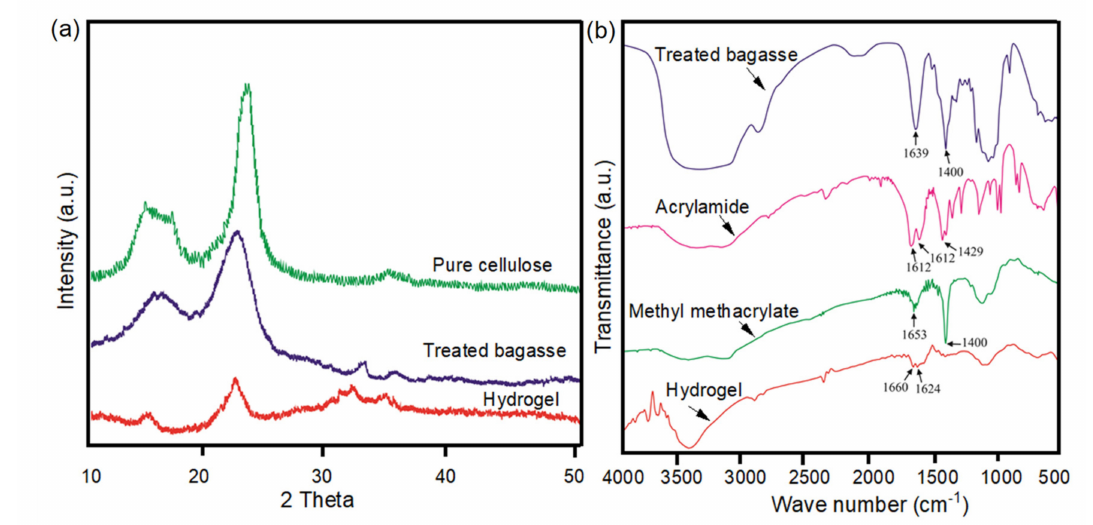
Figure 4. X-ray diffraction pattern of pure cellulose, treated bagasse and its hydrogel ( a ). FTIR spectra of treated bagasse, acrylamide, methyl methacrylate and hydrogel ( b